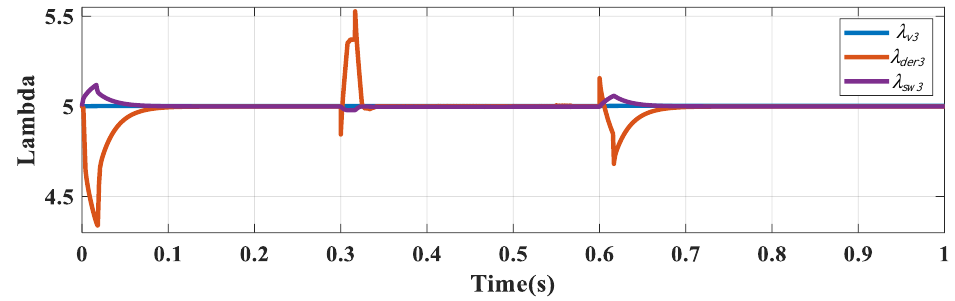
Figure 29. Study 4: generated weighting coefficients for FCS-MPC in